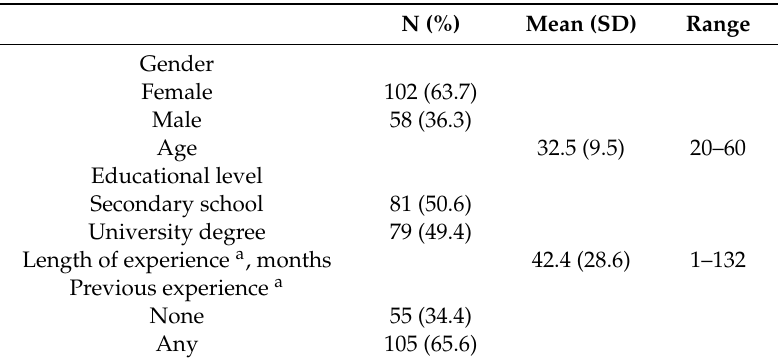
Table 1. Participant characteristics (N =